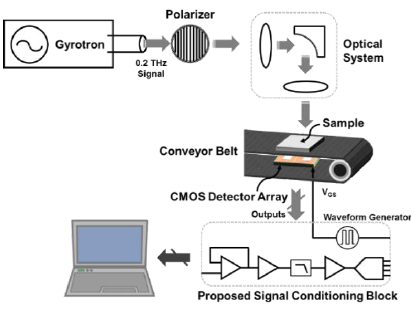
Figure 1. Block diagram of the real-time terahertz (THz) imaging system employing the proposed signal conditioning block of a 1 × 200 CMOS detector array.